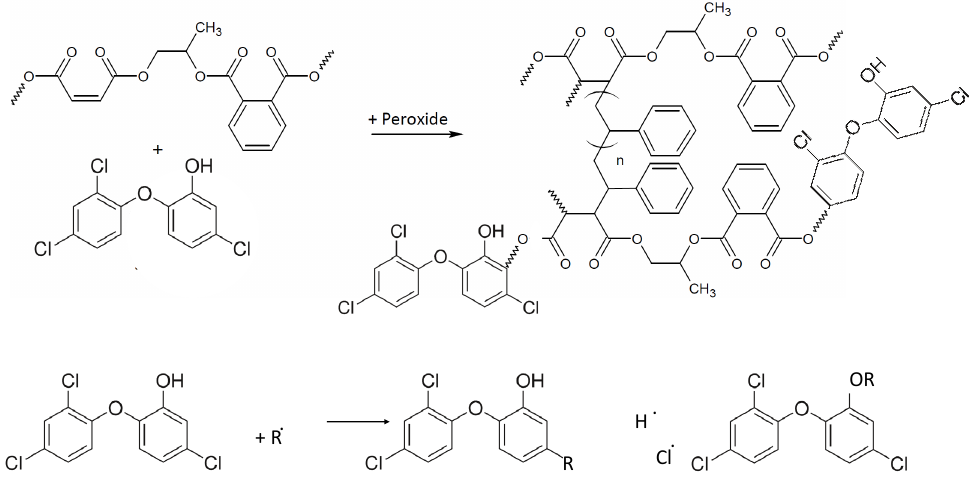
Figure 6. The proposed synthetic reaction of the polymer with triclosan. Table 7. Results of dynamics of antimicrobial activity of the polymer composite with